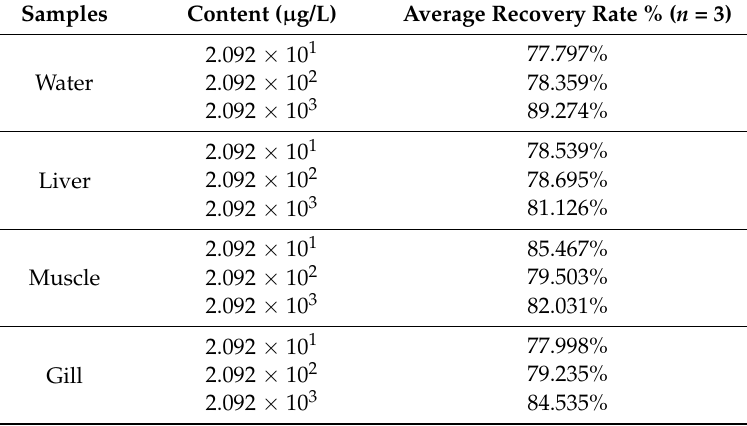
Table 1. Average recovery rate of